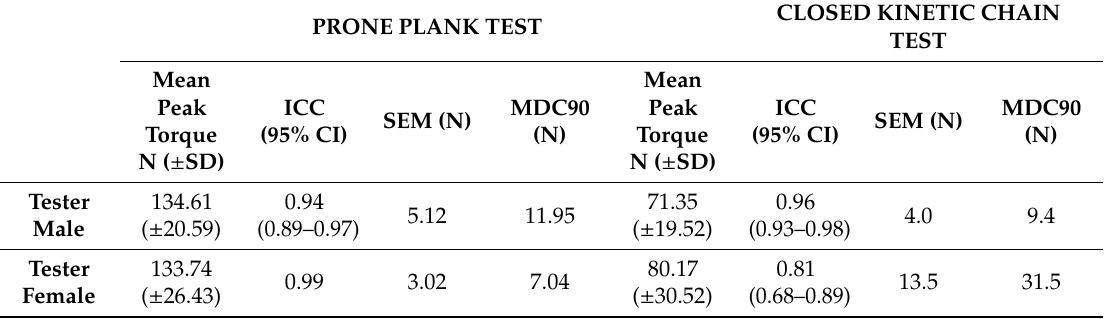
Table 2. Reliability results (N = 22). N = Newton; SD = standard deviation; ICC = intraclass correlation coe ffi cient; SEM = standard error of measurement; MDC 90 = minimal detectable change 90% confidence level.